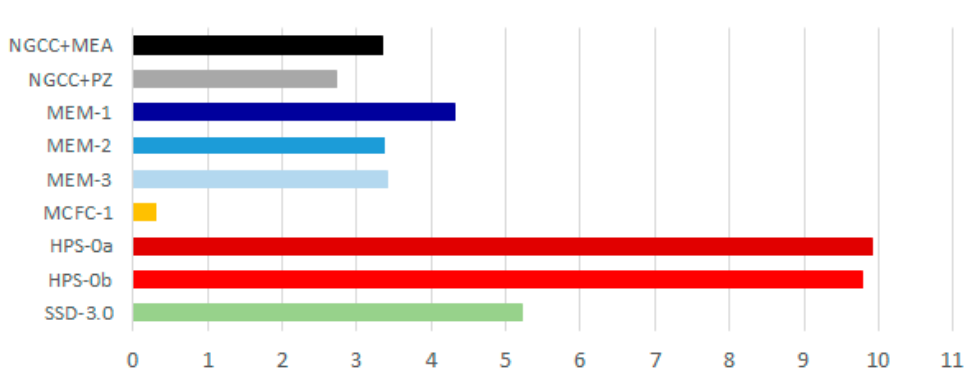
Figure 7. Specific primary energy consumption per unit of CO 2 avoided (SPECCA) index of the assessed technologies.